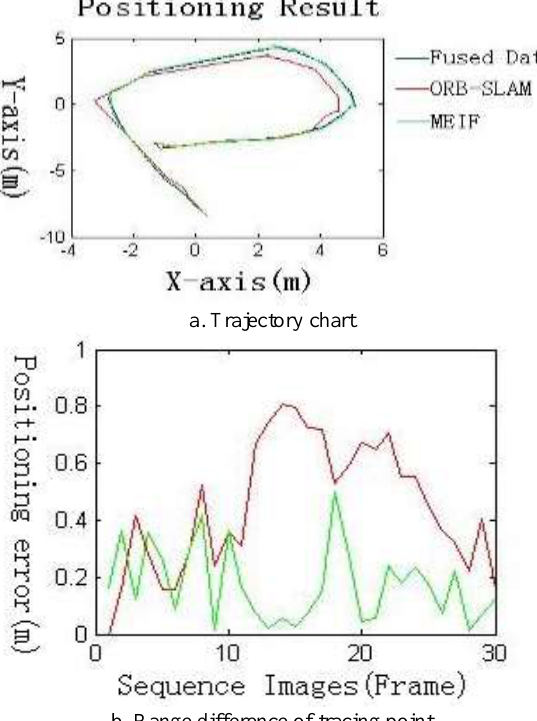
Figure8. Comparative result of trajectory